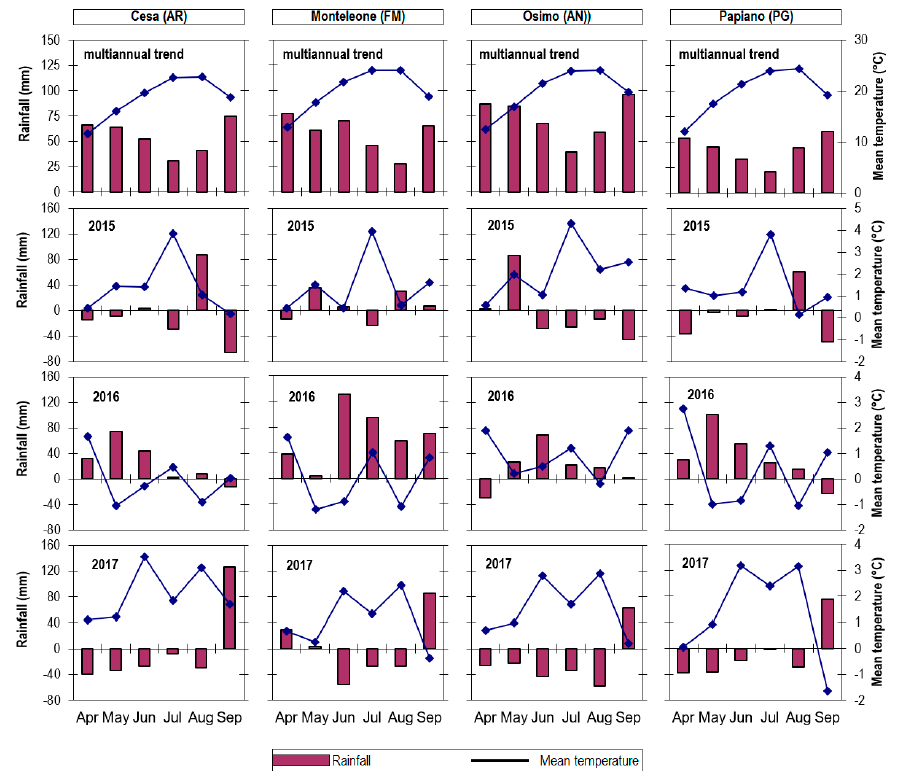
ff erences for the four